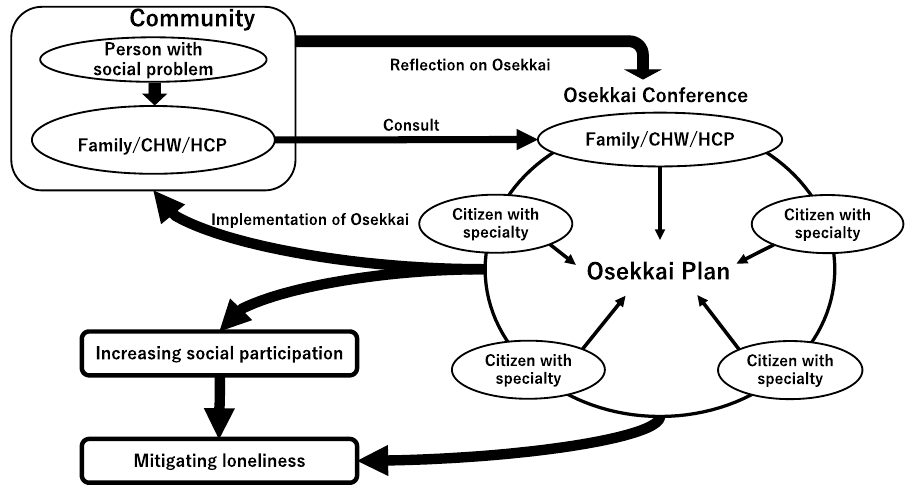
Figure 1. The framework of an Osekkai conference. Notes: CHW, community health worker; HCP, health care